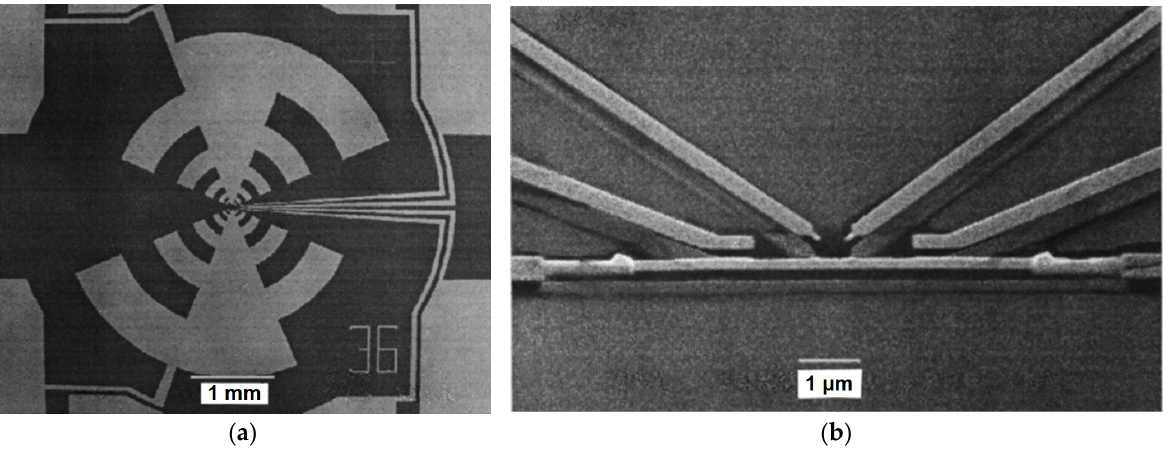
Figure 2. SEM view of ANHEB integrated in log-periodic mode ( a ) and a microbolometer ( b ) [4].